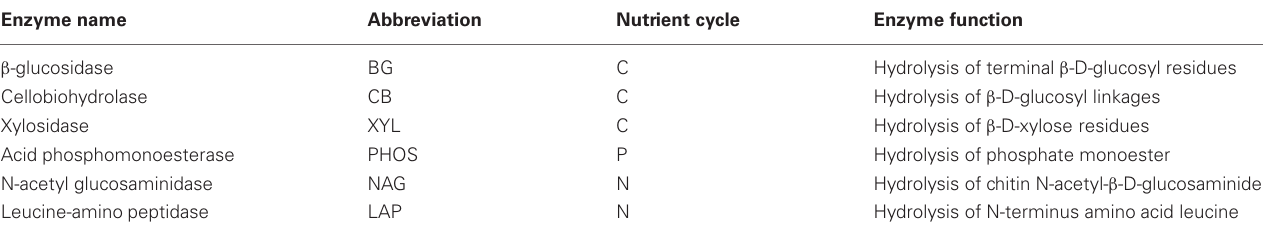
Table 1 | Enzymes assayed in this study, their abbreviations used in the text, nutrient cycles they are involved in, and their target